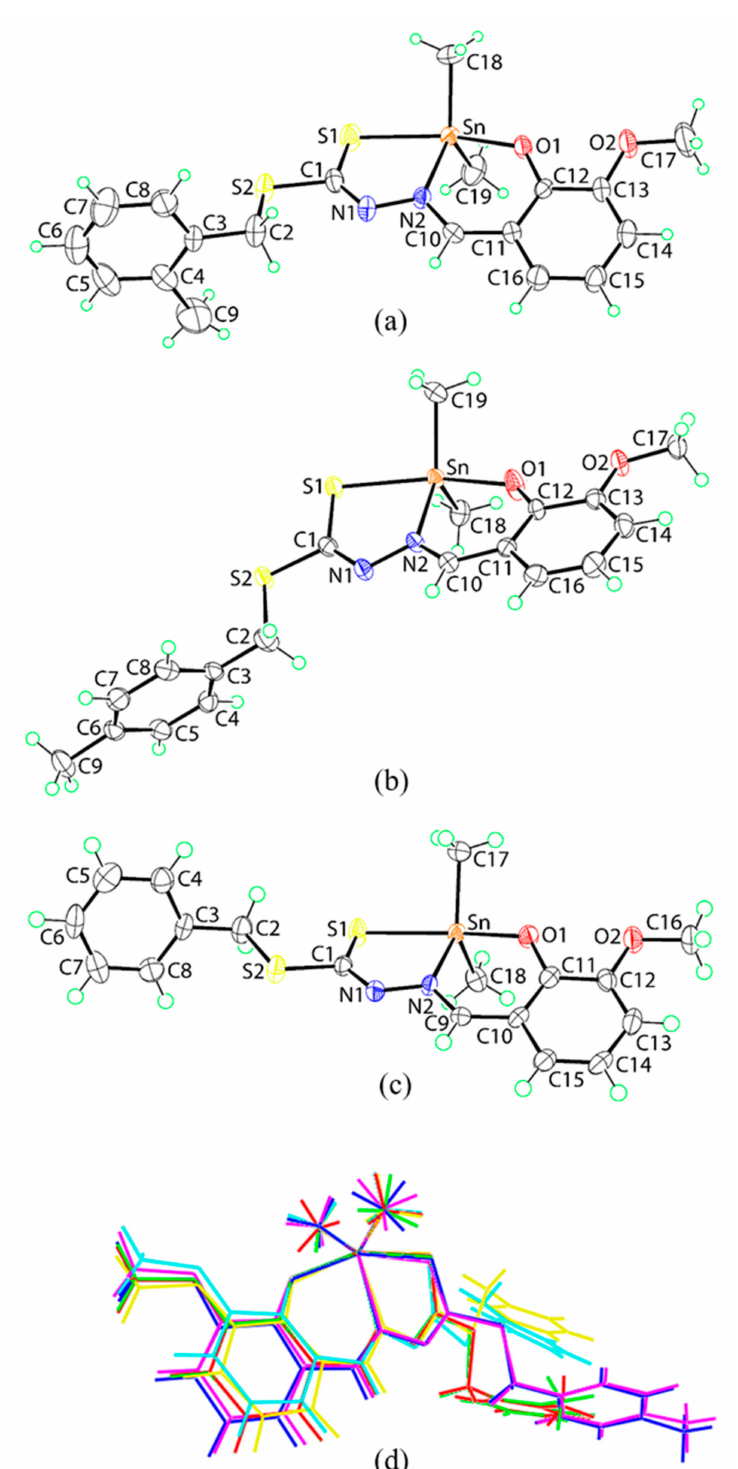
Figure 2. Molecular structures of the first independent molecules of ( a ) Me 2 Sn(S2MoVa), ( b ) Me 2 Sn(S4MoVa) and ( c ) Me 2 Sn(SBoVa) showing atom labelling schemes. ( d ) Overlay diagram of the two independent molecules of each of Me 2 Sn(S2MoVa), a (red image) and b (green), Me 2 Sn(S4MoVa), a (blue) and b (pink), and Me 2 Sn(SBoVa) a (yellow) and b (aqua) with the SnMe 2 planes